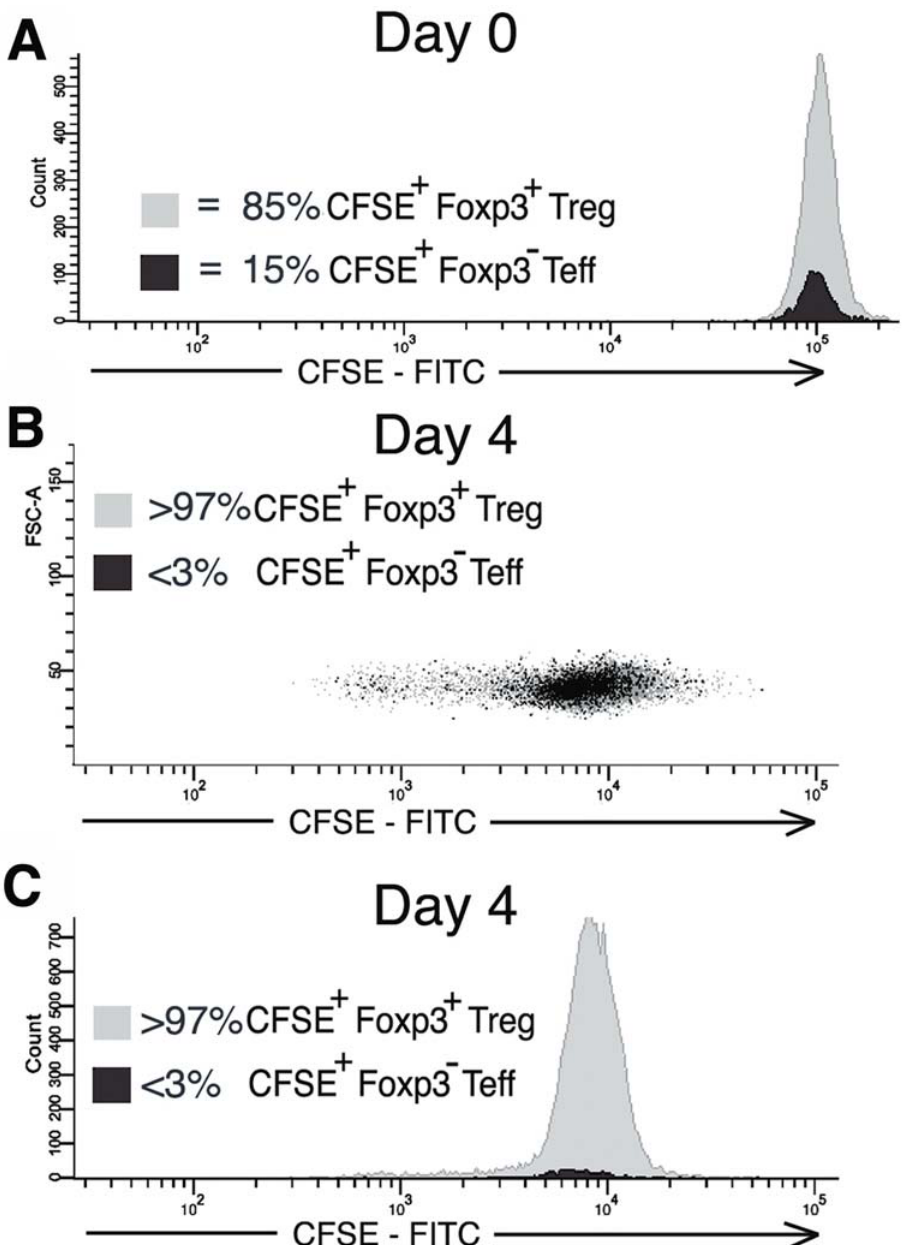
Figure 5. CD4 + Foxp3 2 T eff-conditioned demonstrate impaired invivo survival and proliferation following adoptive transfer. At each time point, an aliquot of CFSE labeled cells was fixed and stained with Pacific-Blue Foxp3 to permit measurement of the ratio T regs and T eff-conditioned . A) Baseline FITC-CFSE fluorescence of expanded CD4 + CD25 + lymphocytes just prior to adoptive transfer. Foxp3 stain demonstrates this exogenous expanded population containing 85% Foxp3 + T regs and 15% Foxp3 2 T eff-conditioined (contaminating T eff cells contained within the expanded T regs population) at the time of transfer. B–C) Dot plot and histogram of the FITC-CFSE fluorescent intensity of both Foxp3 + T regs and Foxp3 2 T eff-conditioned cells recovered from lymphatic and solid organ tissue 4 days after adoptive transfer. Panels B–C demonstrate a significantly reduced survival and proliferation of T eff-conditioned as compared to T regs such that T eff-conditioned comprise , 3% of the recovered CFSE + population. Data reflects typical finding from 6 separate